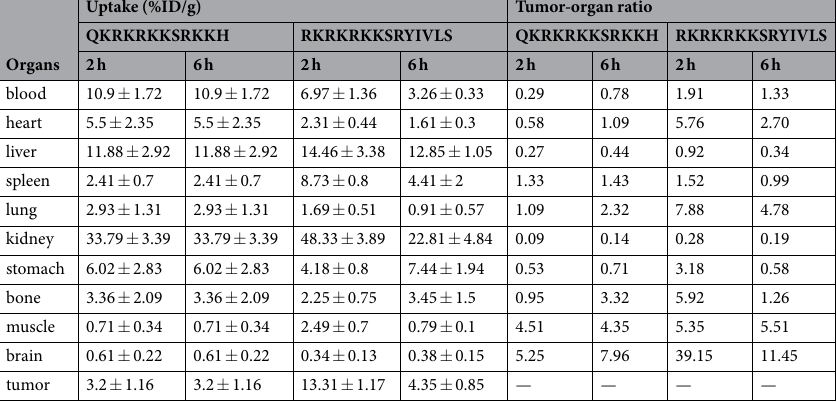
Table 2. Biodistribution data of 188 Re-labeled peptides following intravenous injection into A549 tumor- bearing nude